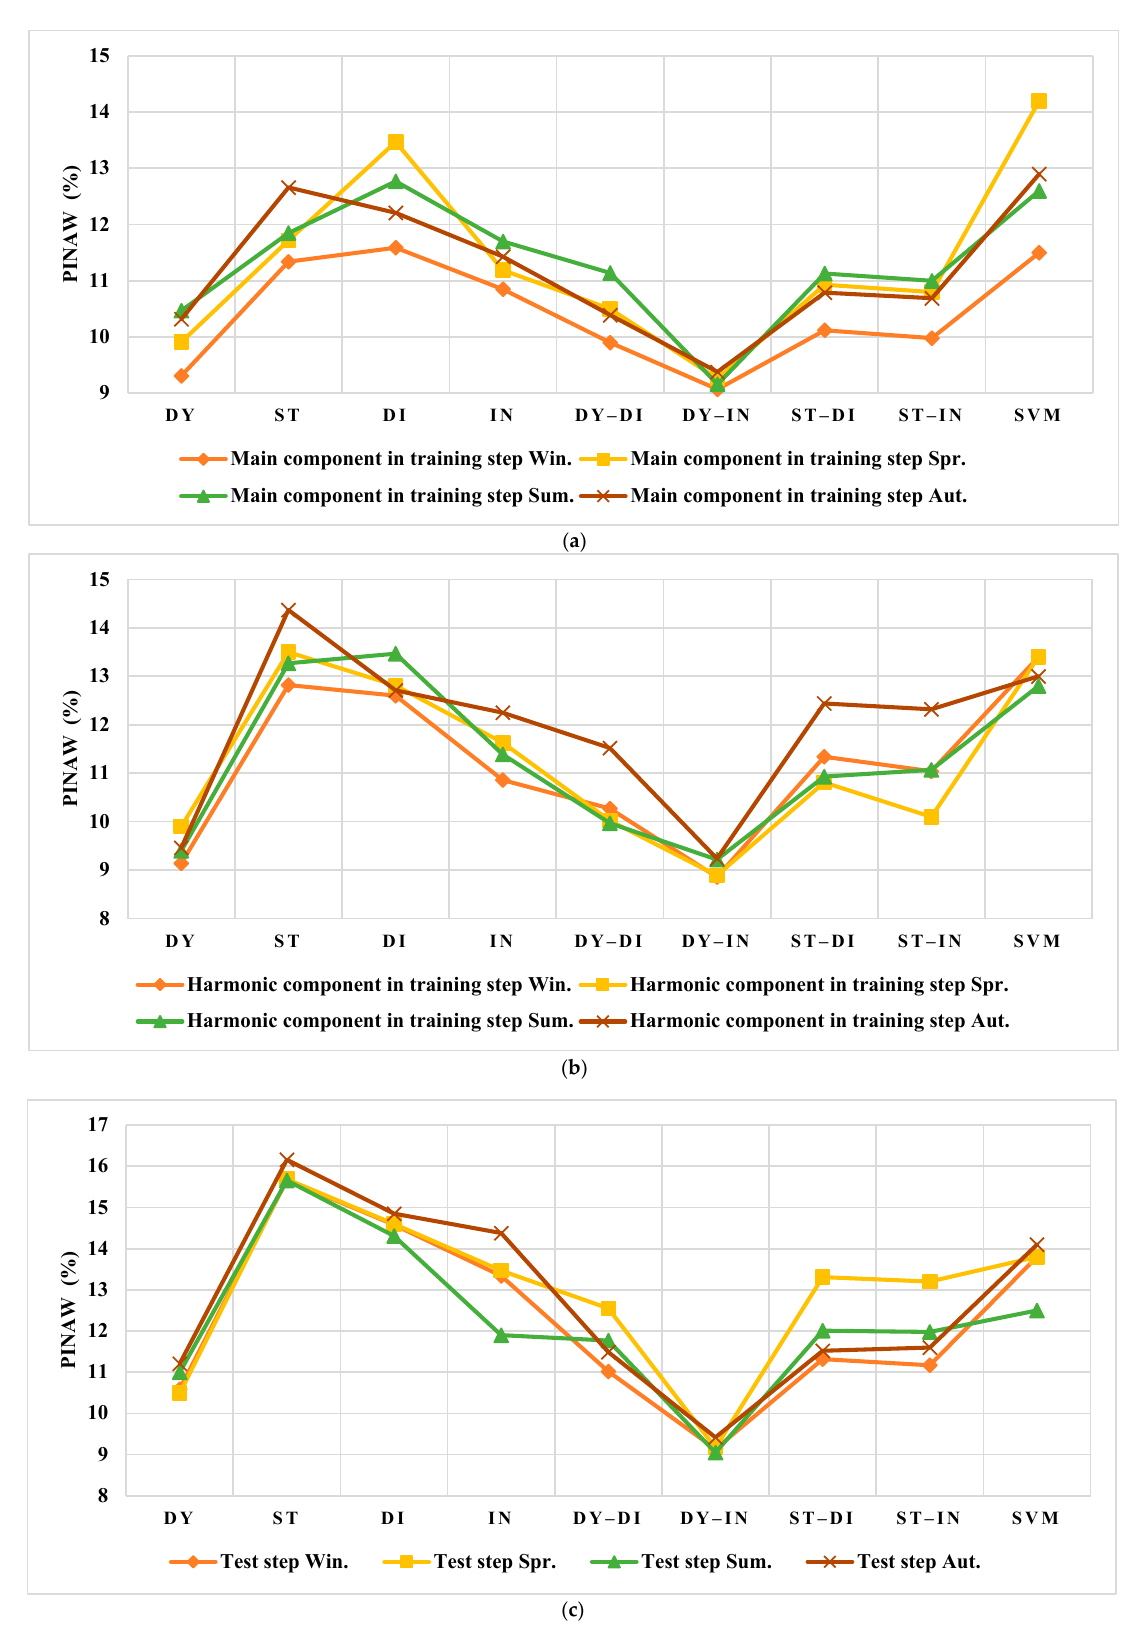
Figure 20. The results of PINAW (%) for the US: ( a ) Main Component in training step, ( b ) Harmonic Component in training step, ( c ) Test step The values of IS by the dynamic indirect GP are closer to zero in comparison to the other methods, especially in the test step results of the static GP, indirect GP, and direct GP. Therefore, based on the information in Figure 21, the best manner is the dynamic indirect GP.